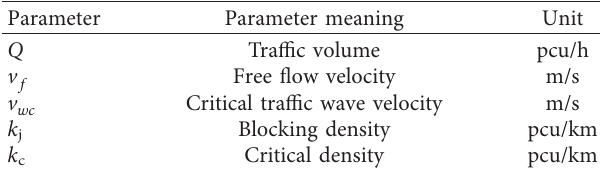
Table 4: Meaning of parameters in